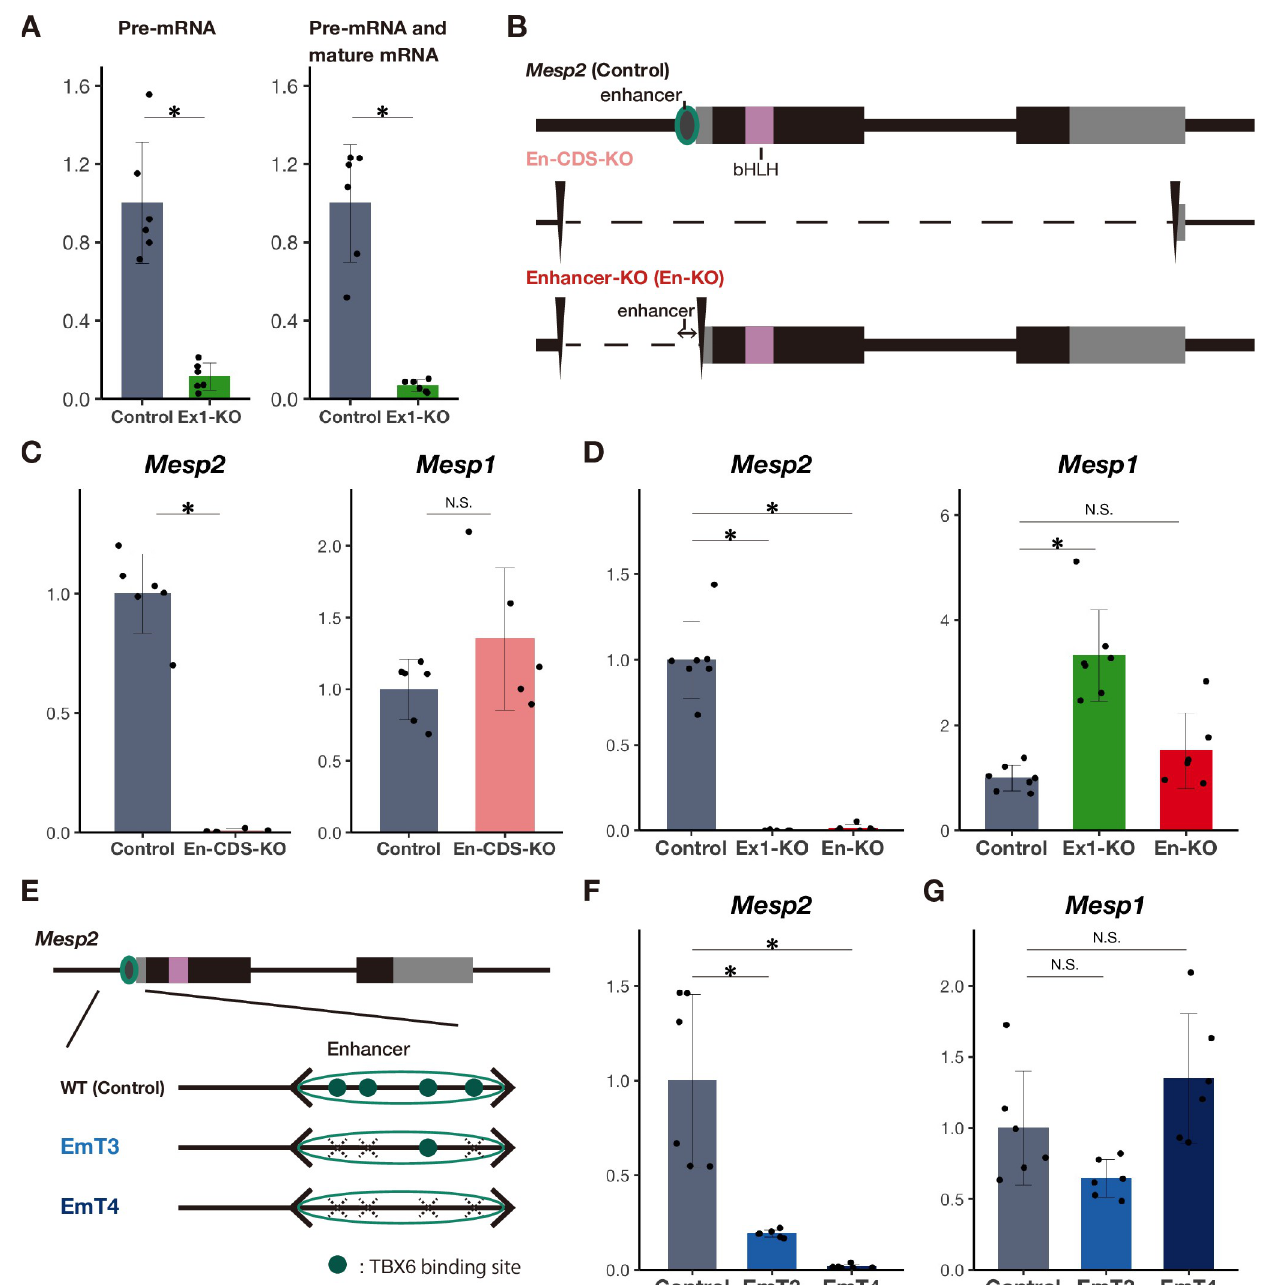
Fig 2. The P2-enhancer is required for the compensatory response. A qPCR analysis of precursor RNA (Pre-mRNA) and either precursor or mature RNA of Mesp2 (n = 6 cultures for each genotype). Used primers are shown in Fig 1D. The expression levels are presented as the ratio against iTbx6;iNICD line (control). B Schematic diagram of Mesp2 genomic deletions of En-CDS-KO and Enhancer-KO. C qPCR analysis of Mesp2 and Mesp1 in in vitro PSM (n = 5 or 6 cultures for each genotype). The expression levels are presented as the ratio against iTbx6;iNICD line (control). P -values were calculated by the Mann-Whitney U test comparing iTbx6;iNICD (control) and iTbx6;iNICD ;P2-En-CDS-KO. Asterisk indicates significant ( p < 0.05). D qPCR analysis of Mesp2 and Mesp1 in in vitro PSM (n = 6 to 7 cultures for each genotype). The expression levels are presented as the ratio against iTbx6;iNICD line (control). P -values were calculated by the Mann-Whitney U test comparing iTbx6;iNICD (control) and iTbx6;iNICD ; Mesp2 -Exon1-KO or iTbx6;iNICD ; P2-Enhancer-KO. Data are presented as the mean ± SD. Asterisk indicates significant ( p < 0.05). E Schematic diagram of mutations of T-boxes in the P2-enhancer. F, G qPCR analysis of Mesp2 (F) and Mesp1 (G) in in vitro PSM (n = 6 cultures for each genotype). The expression levels are presented as the ratio against iTbx6;iNICD line (control). P -values were calculated by the Mann-Whitney U test comparing iTbx6;iNICD (control) and iTbx6;iNICD ; P2-Enhancer mutant lines. Asterisk indicates significant ( p <